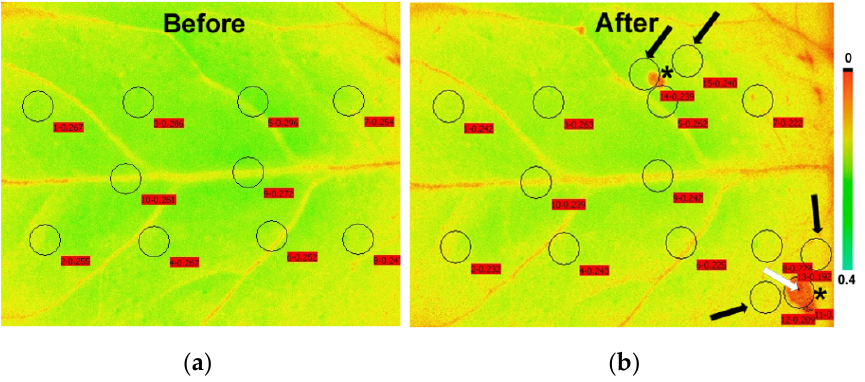
Figure 2. False color image of a tomato leaflet in which the color of each pixel represents the level of Fm (maximum chlorophyll a fluorescence in the dark) at the location showing the position of areas of interest (AOIs). Ten AOIs were chosen before feeding ( a ) while five additional AOIs were chosen after feeding ( b ),at the upper feeding spot (shown by an asterisk), a new AOI (shown by an arrow) was added near the existing AOIs as close as possible to the feeding spot, and another new AOI (shown by arrow) was added as a surrounding zone. At the lower feeding spot (shown also by an asterisk), one new AOI (shown by white arrow) was added in the feeding spot, and two new more AOIs (shown by black arrows) as surrounding zones. The AOIs are complemented by red labels with the F m value at their location. The color code on the right side shows pixel values from 0 to 0.4.